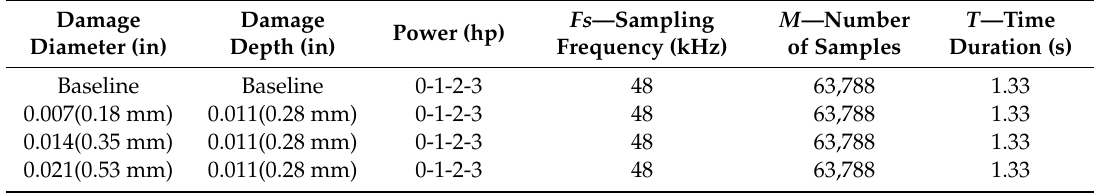
Table 2. Vibration data specifications.